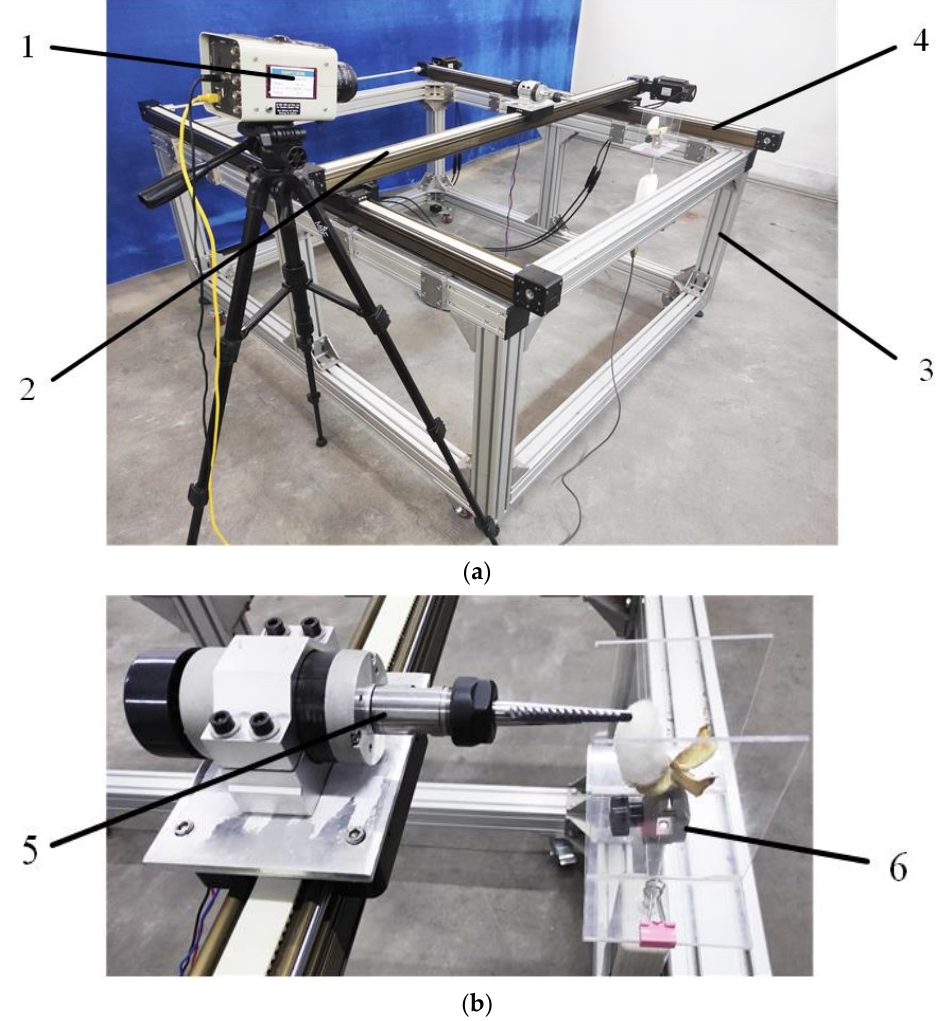
Figure 9. Test bench for dynamic picking performance of the spindle: ( a ) integrated test graph, ( b ) partial schematic (note: the consisting parts of the test apparatus are: 1. high-speed camera, 2. X-direction guide rail, 3. frame, 4. Y-direction guide rail, 5. picking ingot driving device, 6. cotton clamping force-measuring device).